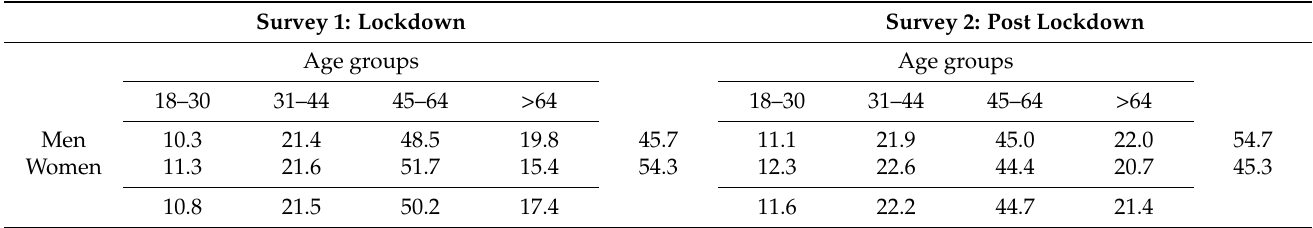
Table 1. Age-Gender distributions of the collected data (percentages).